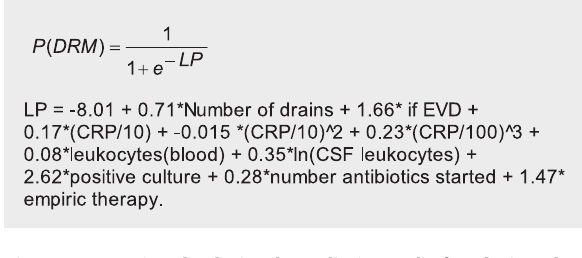
Figure 1. Previously derived prediction rule for drain-related meningitis. For each individual patient, the model returns a predicted probability of DRM which can be used to classify patients. Abbrevia- tions: P(DRM) – probability of drain-related meningitis, LP – linear predictor, EVD – external ventricular drain, CRP – C-reactive protein, CSF – cerebrospinal